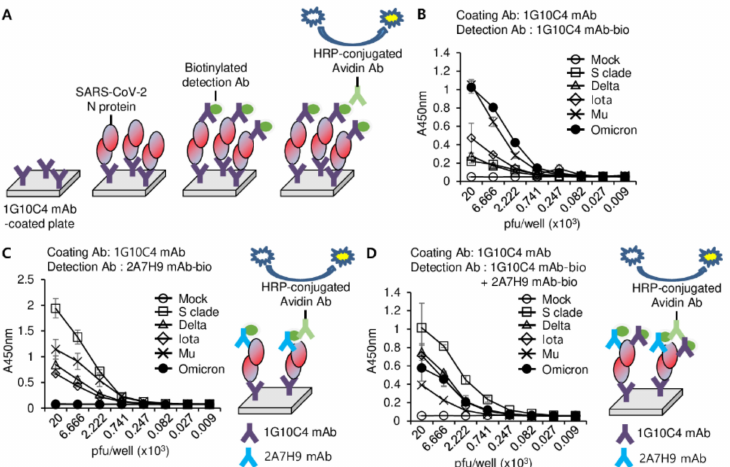
Figure 5. Detection of the N protein in virus particles of SARS-CoV-2 variants using anti-SARS-CoV-2 N protein-specific mAbs. ( A ) Schematic of the detection system. ( B – D ) SARS-CoV-2 S clade, delta, iota, mu, and omicron variants in cell culture supernatants were lysed with cell lysis buffer. Ninety- six-well immunoplates were coated with 100 ng/well of 1G10C4 mAb, and then serially diluted lysates of the indicated SARS-CoV-2 variants were added. After washing with PBST, 100 ng/well of biotinylated 1G10C4 mAb ( B ), biotinylated 2A7H9 mAbs ( C ), or a mixture of the biotinylated 1G10C4 and biotinylated 2A7H9 mAbs ( D ) was added, and then the titration curve was obtained by an ELISA using peroxidase-conjugated avidin